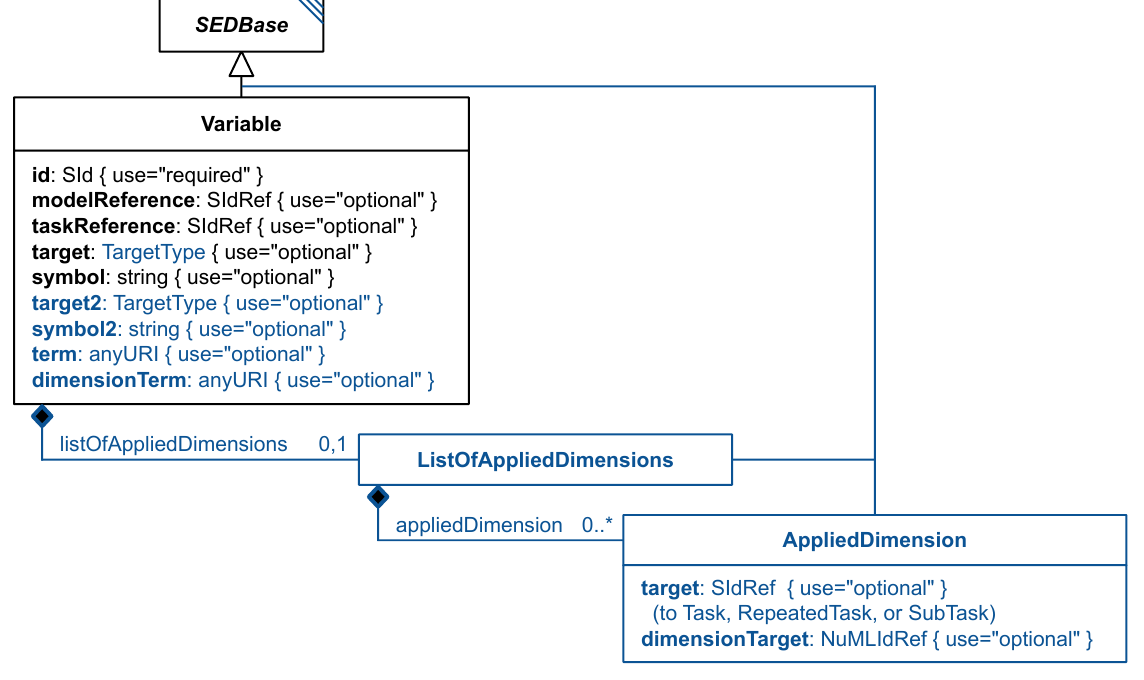
Figure 2.5: The Variable, ListOfAppliedDimensions, and AppliedDimension